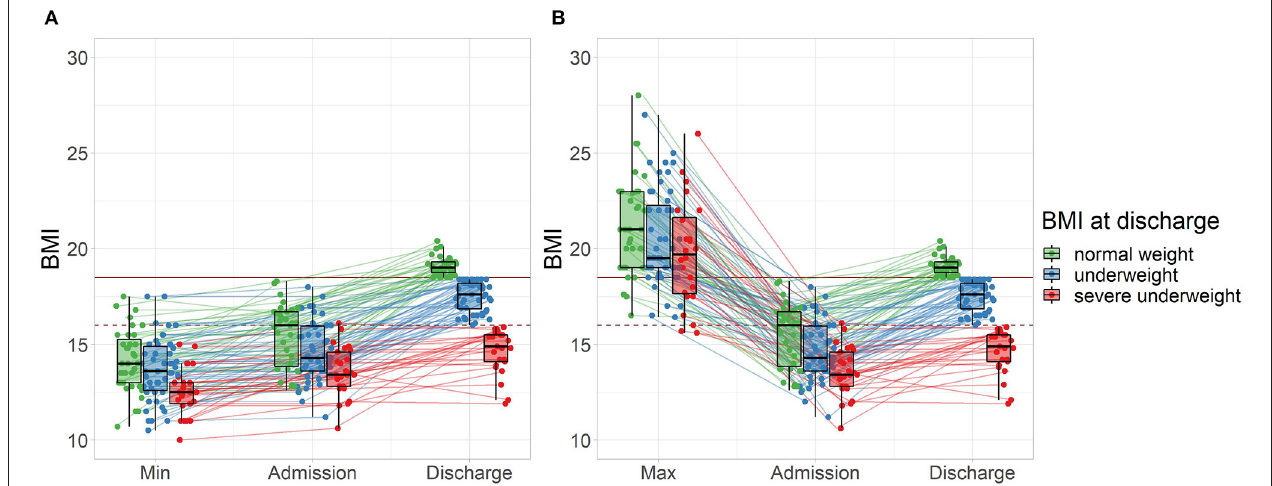
FIGURE 1 | Treatment outcome and lifetime weight characteristics of all patients ( n = 107) grouped by BMI at discharge. (A) Minimal lifetime BMI. (B) Maximal lifetime BMI (two patients with a maximal BMI > 30 are not displayed). The horizontal mark of the boxplots signifies the median, edges of the box represent 25 and 75th percentiles, and the whiskers extend to 1.5 interquartile ranges. Normal weight: BMI ≥ 18.5 kg/m 2 , represented by the solid horizontal line, severe underweight: BMI < 16.0 kg/m 2 , represented by the dashed horizontal line.